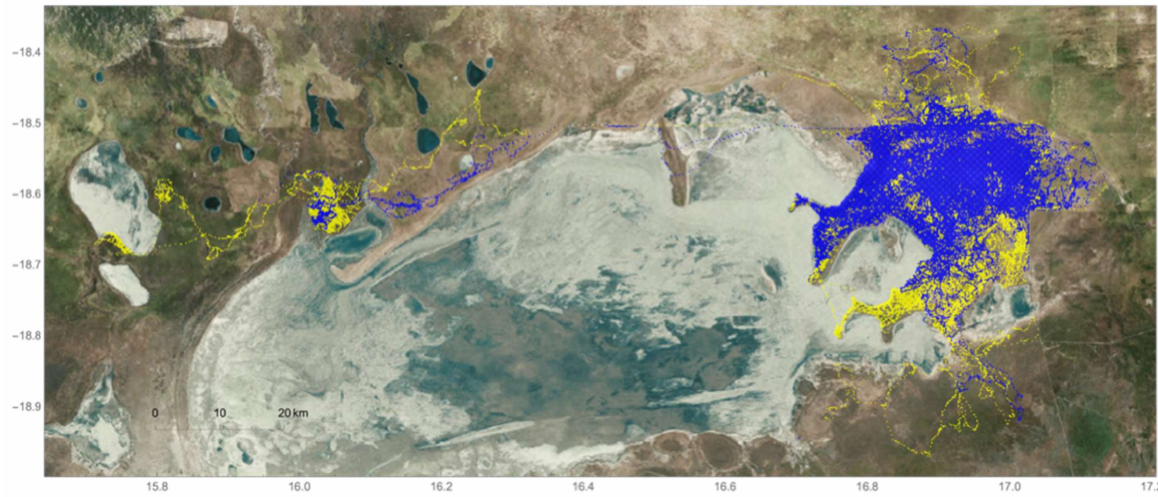
Figure 5. Movement data of male African elephants (ID #264, 265 266, 267, and 268) across the northeastern region of Etosha National Park (ENP), Namibia and collected between October 2009 and November 2011 using GPS collars. Elephant movement during the wet season (May–October) is showcased in blue and movements during the dry season (November–April) in yellow.